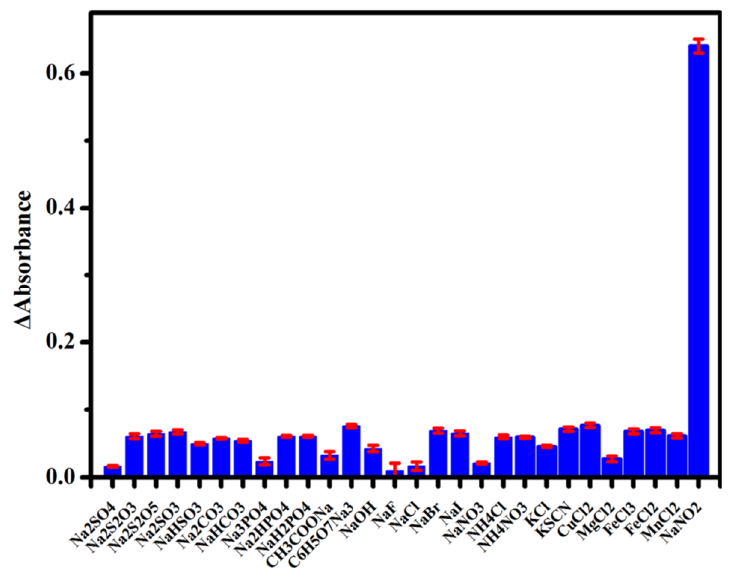
Figure 6. ∆ A at 532 nm of the sensing platform for NaNO 2 (35 µ M) and other analytes (350 µ Figure 6. ΔA at 532 nm of the sensing platform for N aNO 2 (35 μM) and other analytes (350 μM).